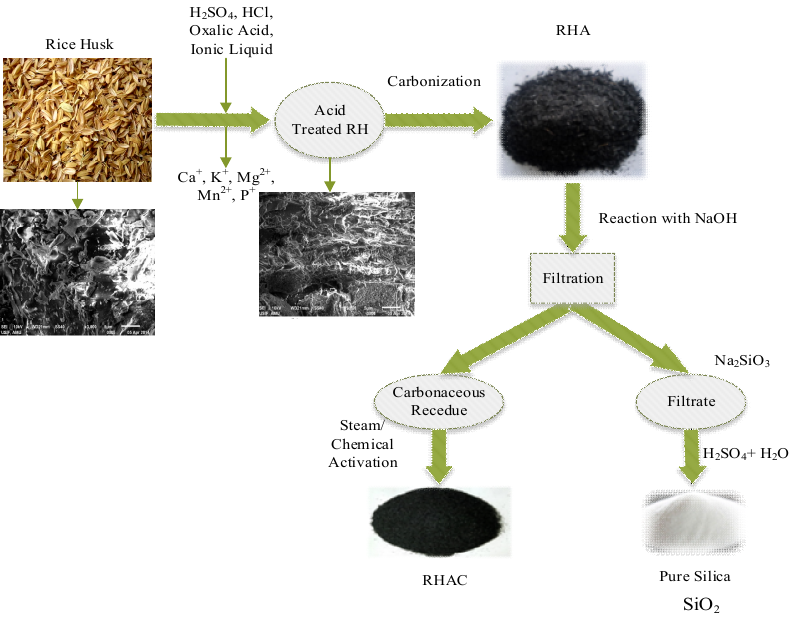
Figure 1. Overview on the preclearing and activation processes of Rice husk (RH) for activated carbon (AC) production. RH ash (RHA): RH ash. In figure, Ca 2 + , K + , Mg 2 + , Mn 2 + , P and H 2 SO 4 indicates calcium ion, potassium ion, magnesium ion, manganese ion, phosphorous, and sulfuric acid, respectively. Reproduced with permission from [1,47,72]. Elsevier and Copyright Clearance Center, 2009; Copyright © 2008, & Copyright © 1997, American Chemical Society, respectively.